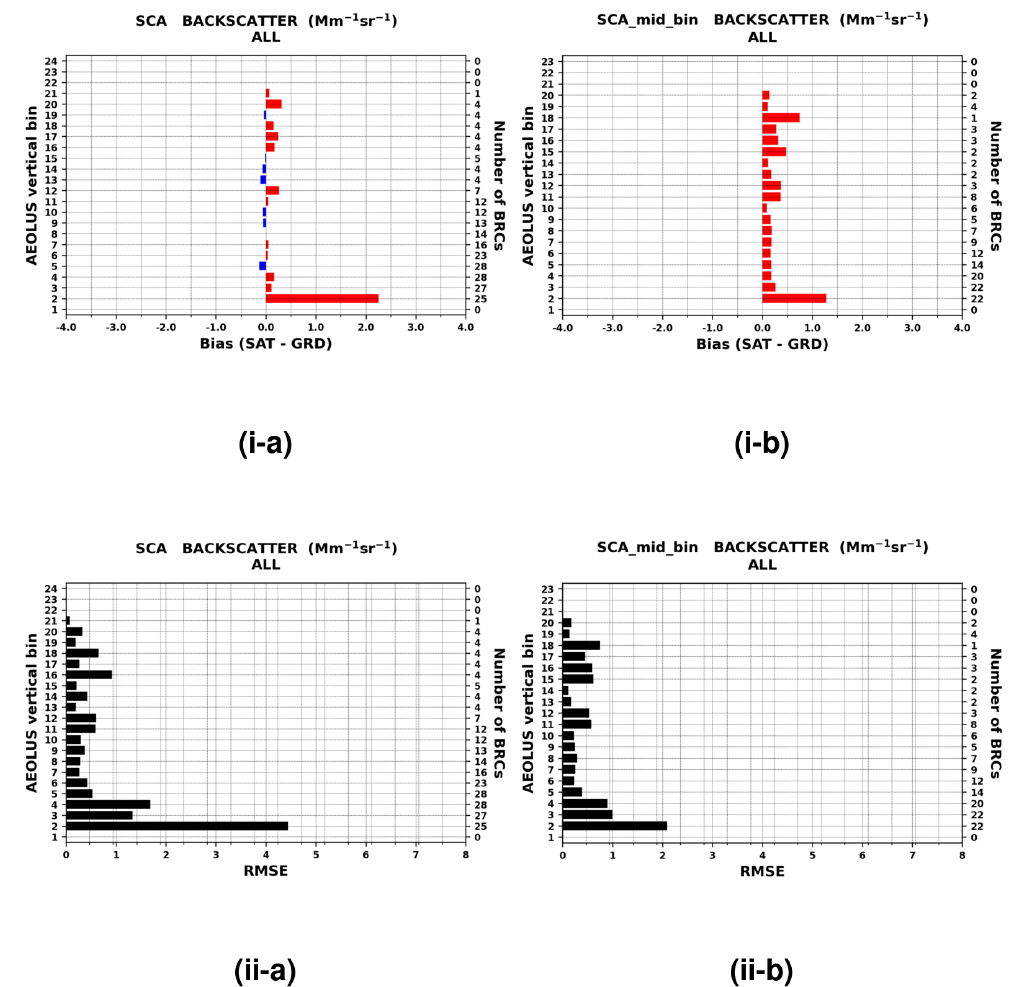
Figure 5. As in Fig. 4 but for the filtered Aeolus L2A backscatter